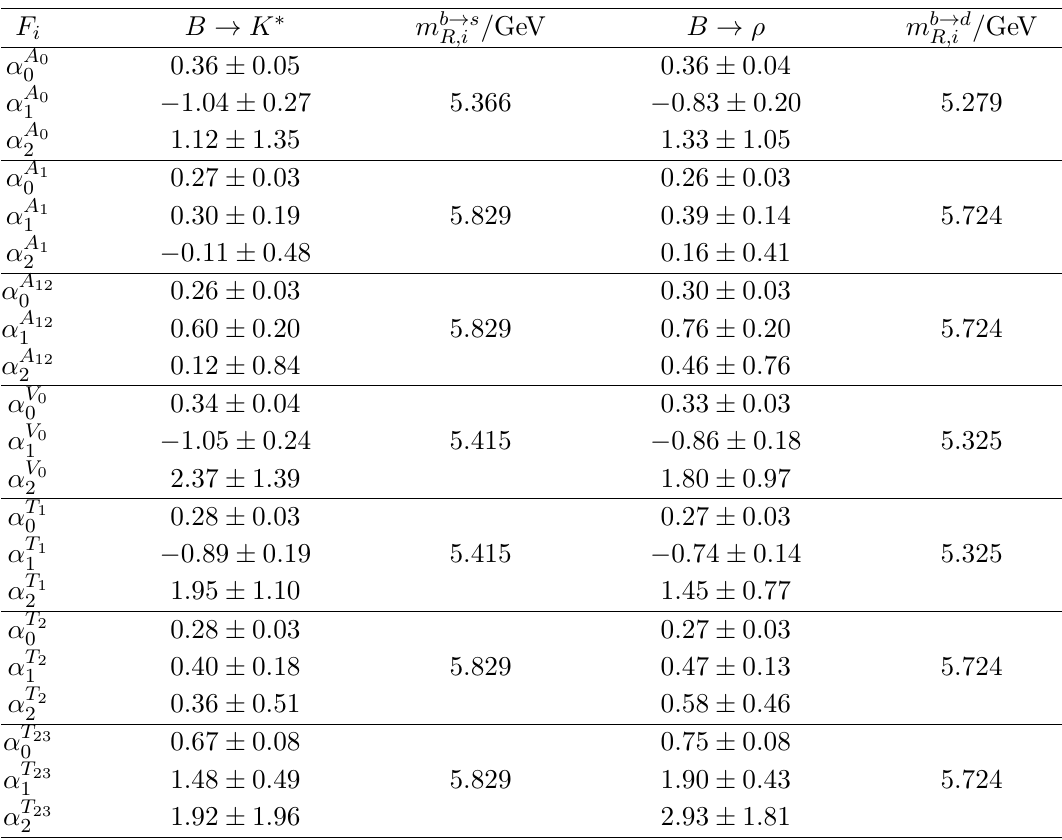
Table 5 . Parameters in the form factors of the B → ρ ( K ∗ ) processes with k max = 2